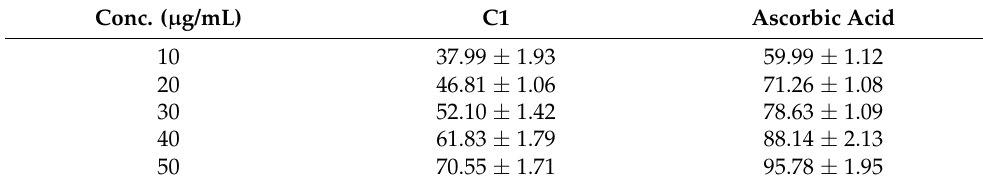
Table 11. NO scavenging capacity of